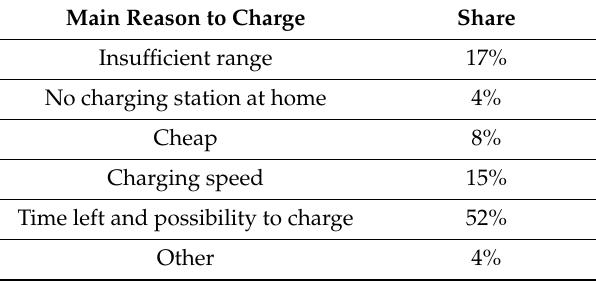
Table 4. Main reason to